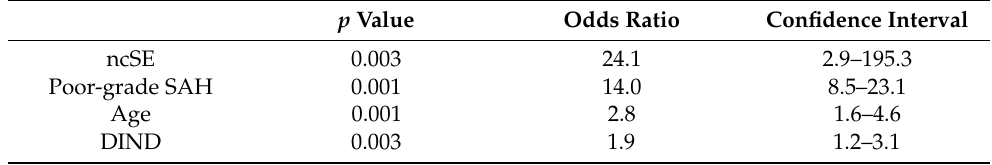
Table 2. Multivariate analysis for